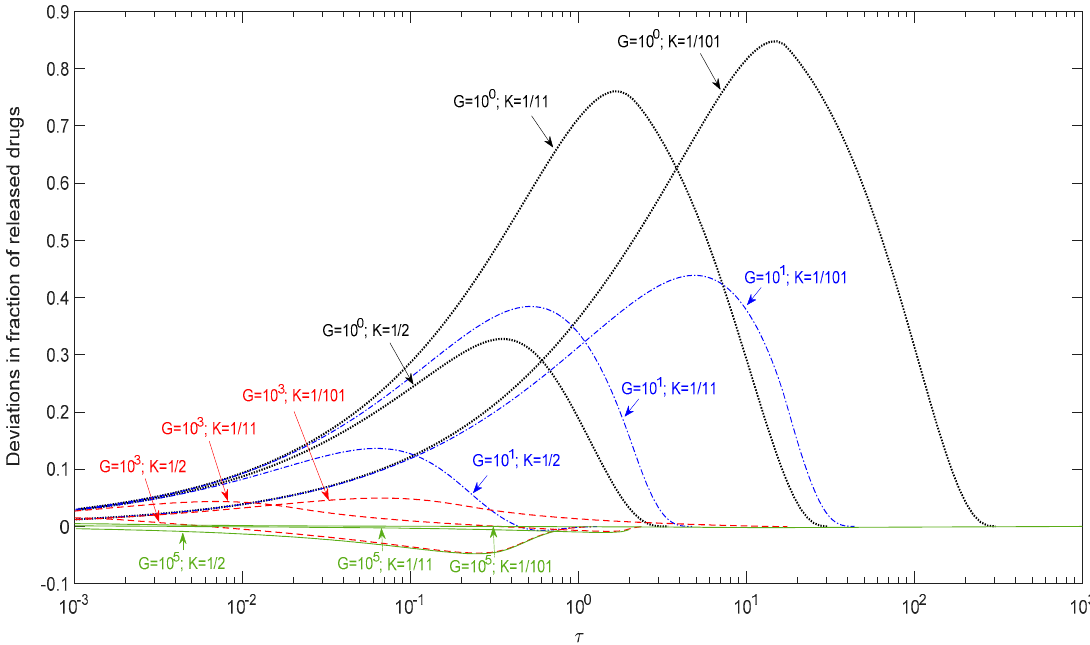
Figure 5. Deviations between Higuchi’s model and this present model for n = 2/3.